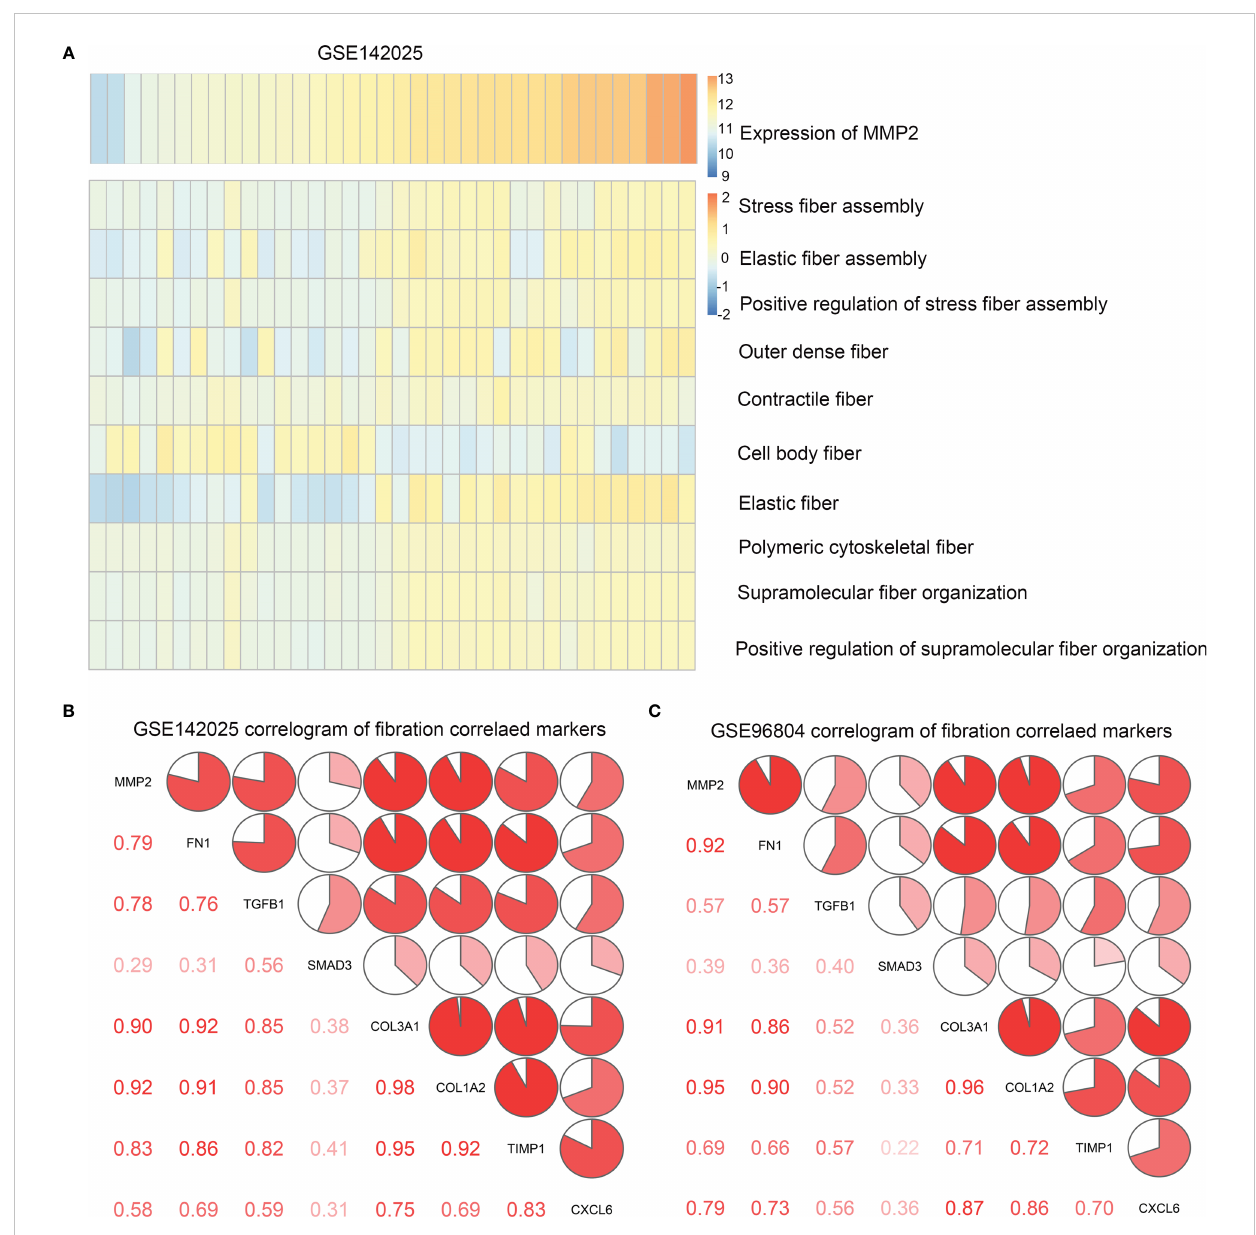
FIGURE 4 (A) Heat map of correlation between MMP2 expression and fi brosis function enrichment score. The samples were arranged in ascending order of MMP2 expression. (B) Correlation between MMP2 and fi brosis gene in data sets GSE142025, (C) GSE96804. Correlation coef fi cients are shown in the lower left corner. In the upper right, the correlation coef fi cients are also shown to be pie chart